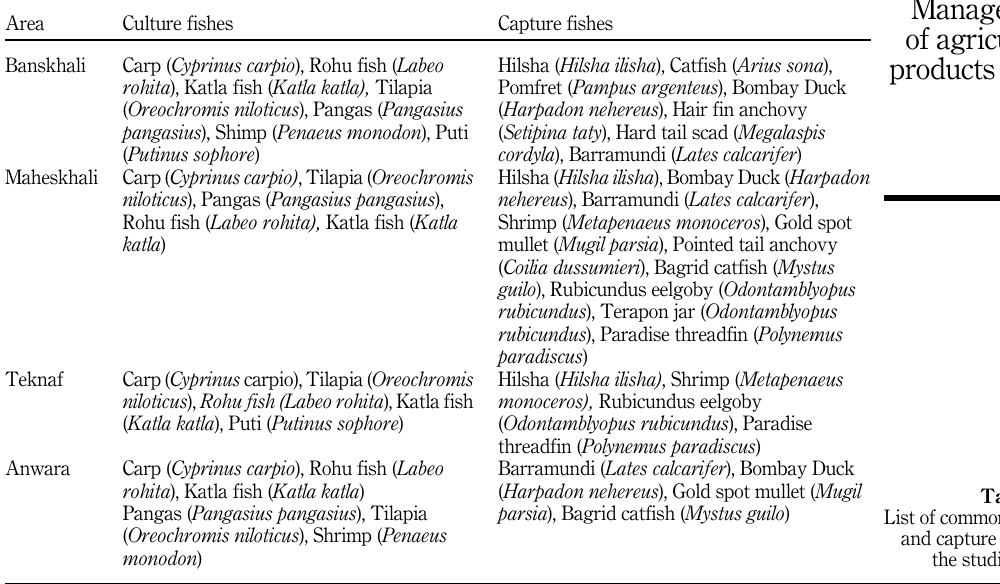
Table 12. List of common culture and capture fishes in the studied